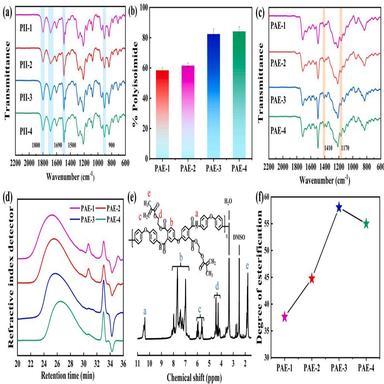
(a) FT-IR spectra of PIIs, (b) Polyisoimide content, (c) FT-IR spectra of PAEs, (d) 1 H NMR spectrum of PAEs, (e) GPC trace of PAEs, (f) esterification rate of PAEs.